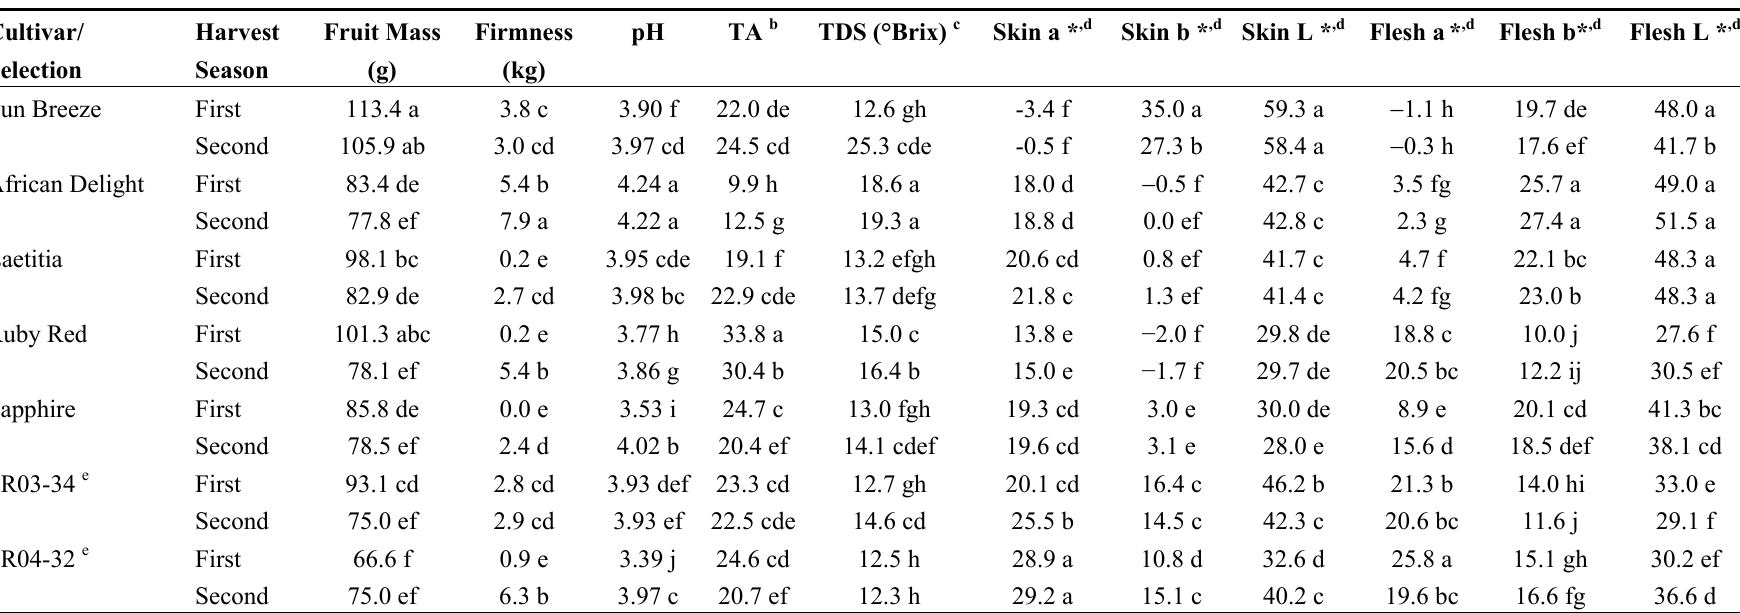
Table 6. Fruit attributes for ripe fruits from South African plum ( Prunus salicina Lindl.) cultivars and selections harvested during two consecutive harvest seasons a